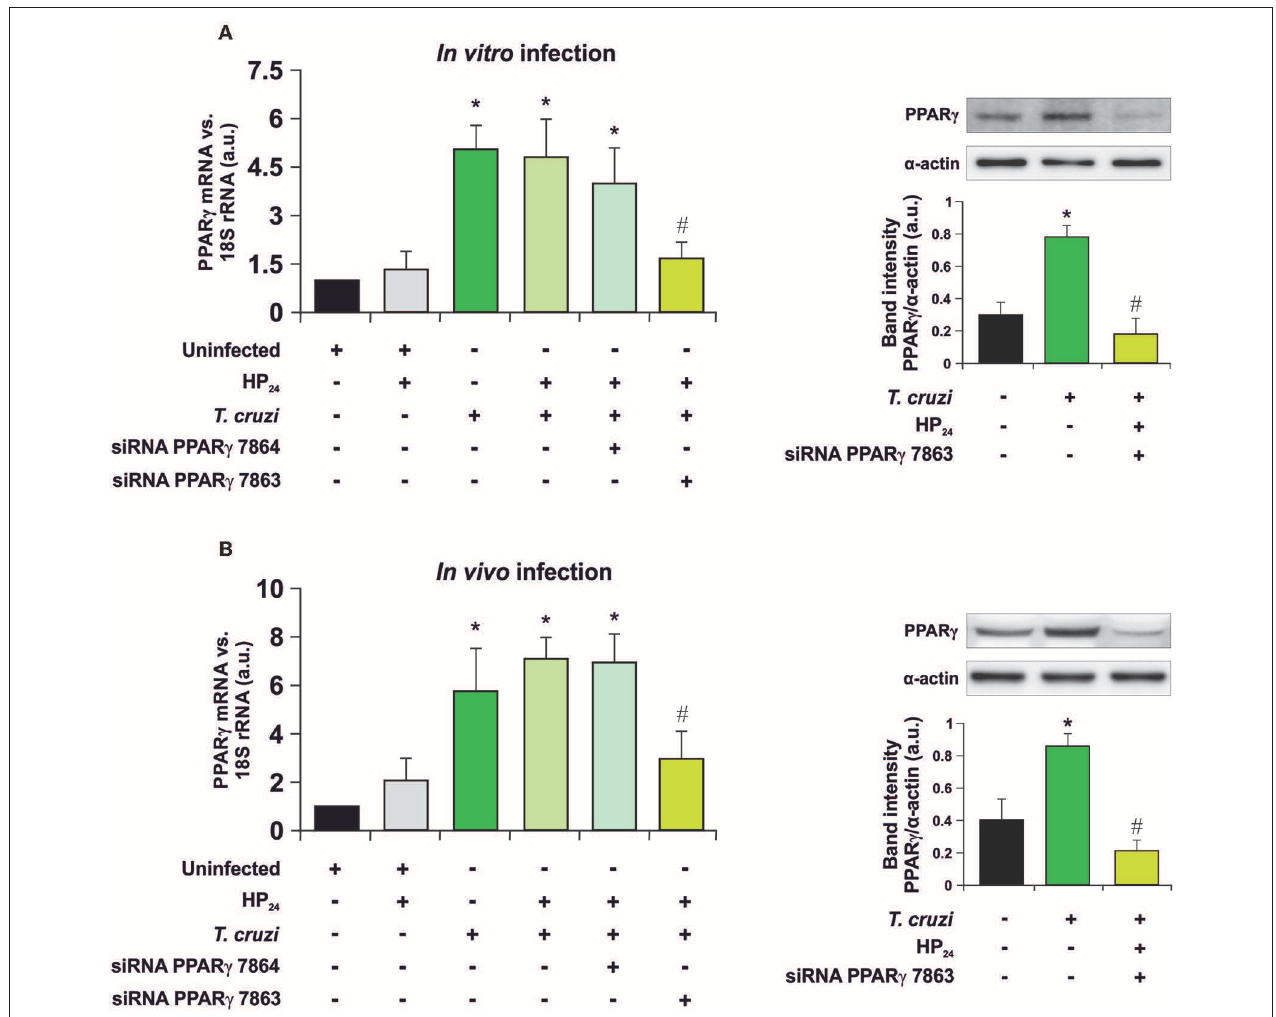
FIGURE 1 | PPAR γ silencing. (A) Uninfected peritoneal macrophages were obtained and, alternatively, transfected with two different PPAR γ -siRNA during 72h. Transfected or non-transfected cells were treated with HP 24 (100 µ M) since 30min before infection. These cells were infected for 48h with T. cruzi (parasite:cell ratio 5:1). (B) Peritoneal macrophages from T. cruzi -infected mice (9 dpi) were obtained. These cells were alternatively transfected with two different PPAR γ -siRNA for 72h. Transfected or non-transfected cells were treated with HP 24 (100 µ M) for 48h. PPAR γ expression was analyzed by RT-qPCR (six mice/group). Expression of PPAR